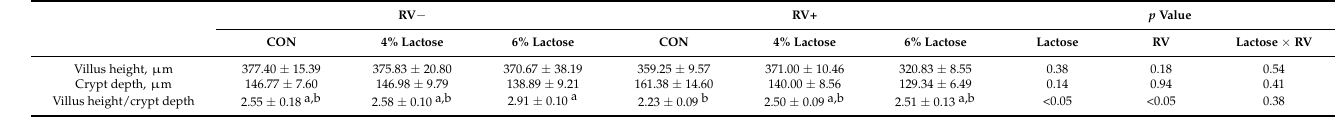
Table 8. Effect of dietary lactose supplementation and/or RV challenge on morphology of jejunal mucosa in weaned pigs 1